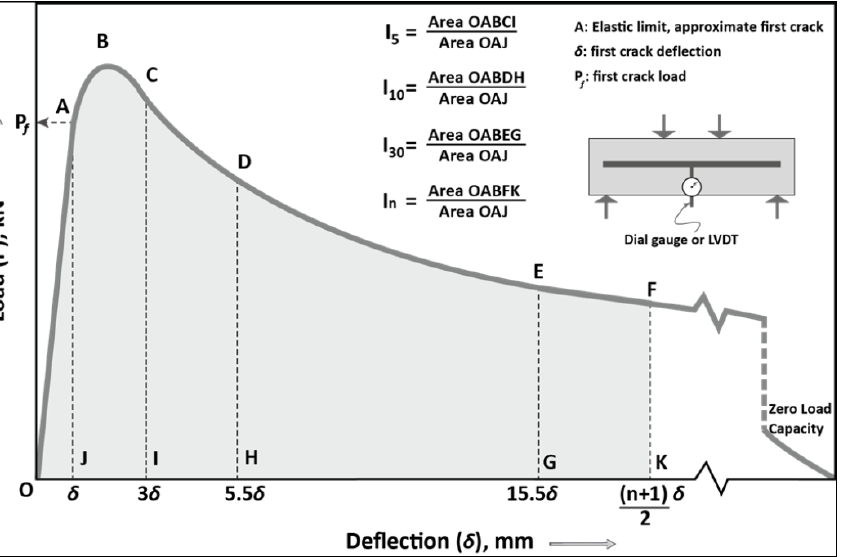
Figure 3. Definition of Toughness Indices (load-deflection curve) according to ASTM C1018